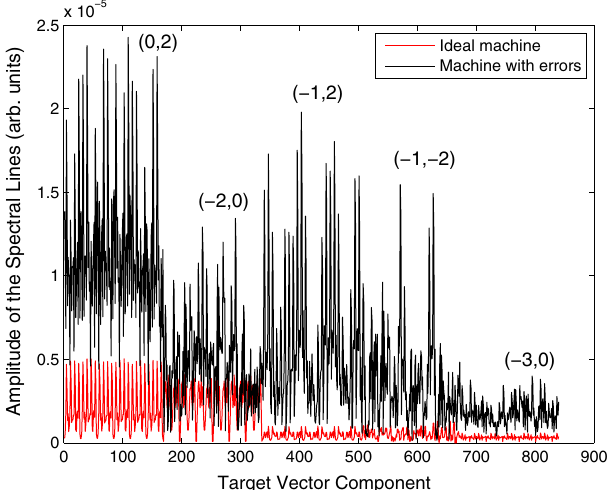
FIG. 3. (Color) Assigned sextupole components (blue) and their reconstructed values with the numerical fit (red).